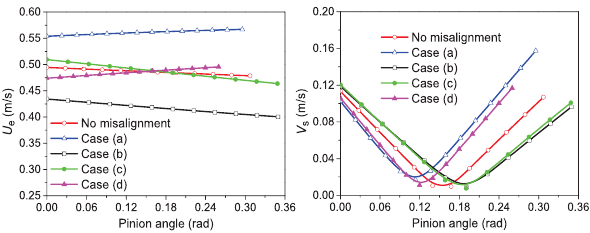
Fig. 8 Entrainment velocity and sliding velocity in a mesh cycle.